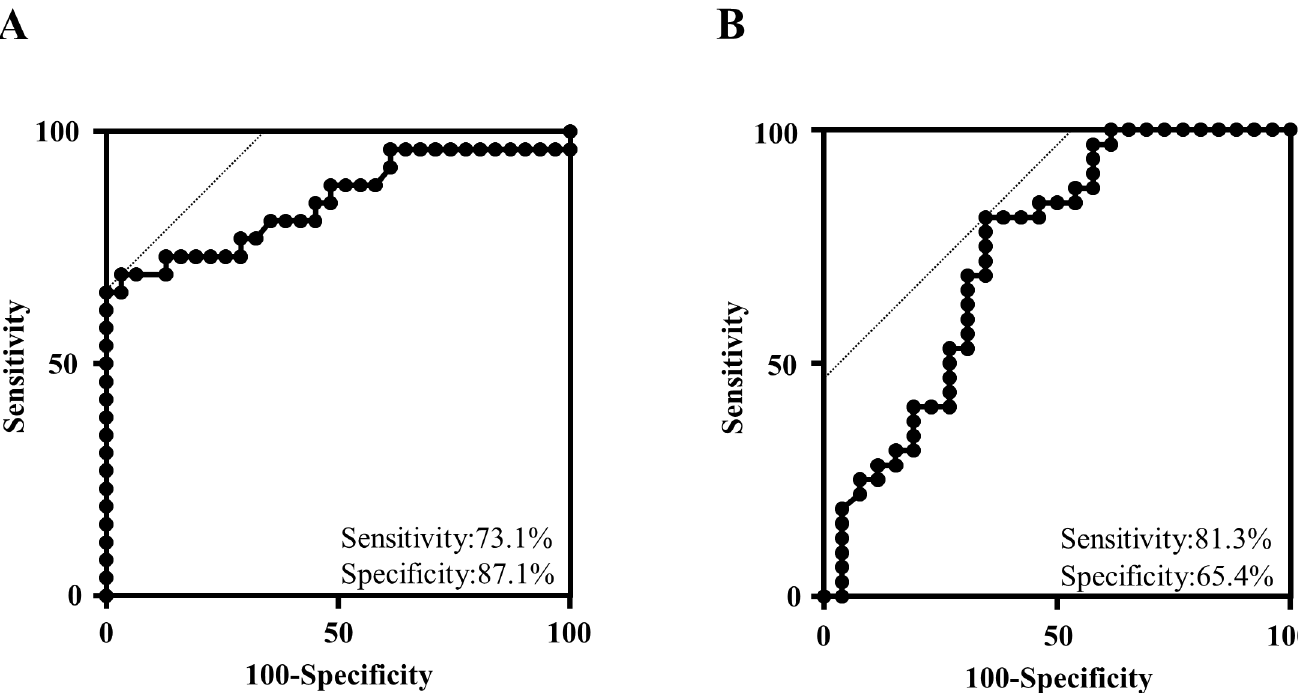
Fig 5. ROC analysis of anti-CD300e antibody. A: ROC analysis of patients with FT1D in the acute phase (n = 26) and HC (n = 30). B: ROC analysis of patients with FT1D in the acute phase (n = 26) and T1AD (n = 32).